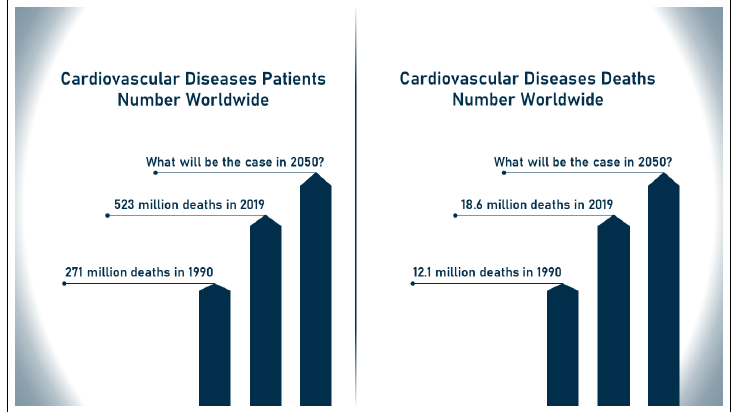
Figure 1. Increase in number of patients and deaths due to